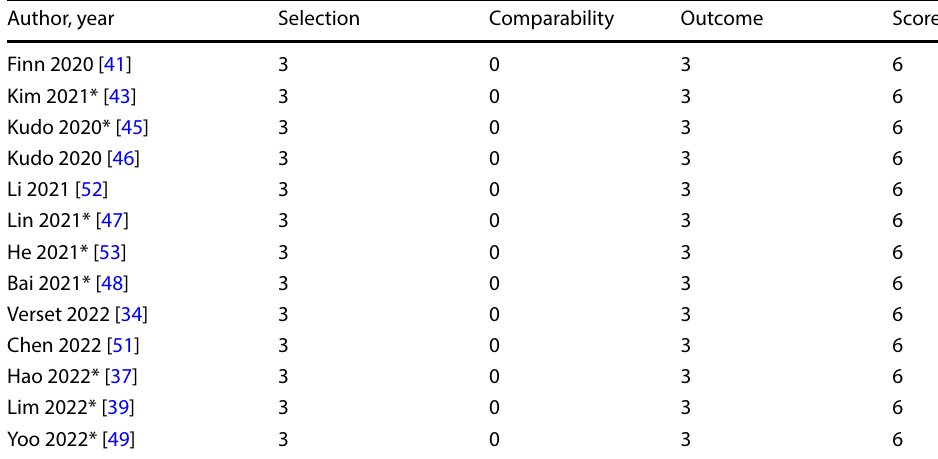
Studies marked with asterisk are conference